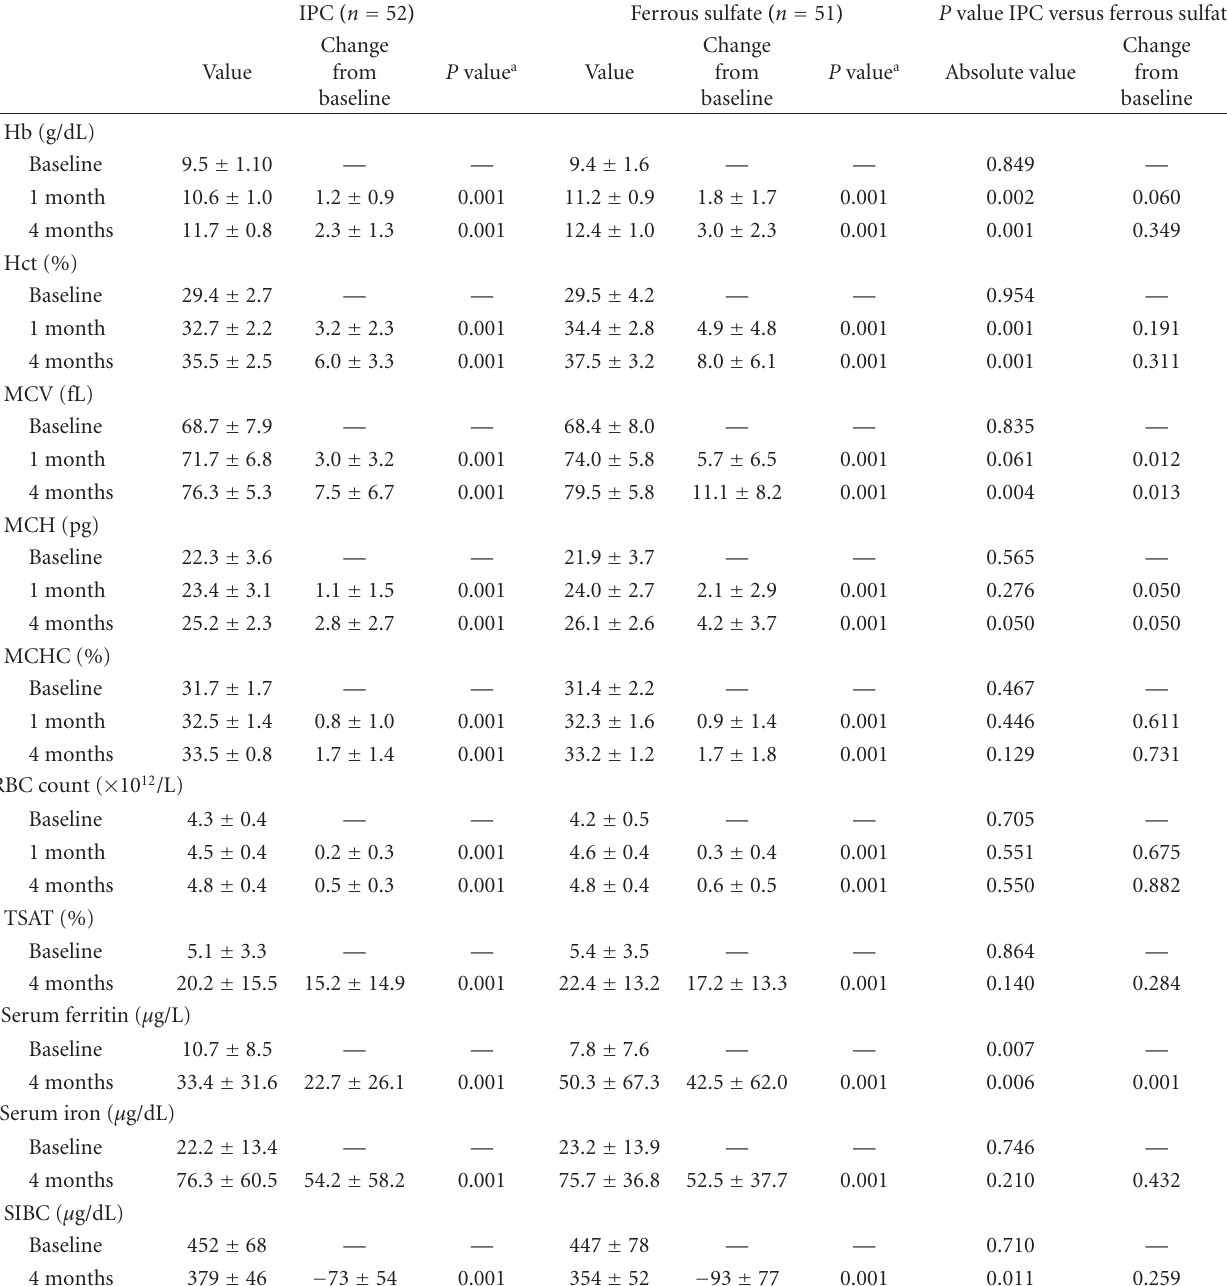
Table 2: Baseline values and changes in erythrocyte-related hematologic and iron status parameters in pediatric patients with iron deficiency anemia receiving oral iron therapy with iron hydroxide polymaltose complex (IPC) or ferrous